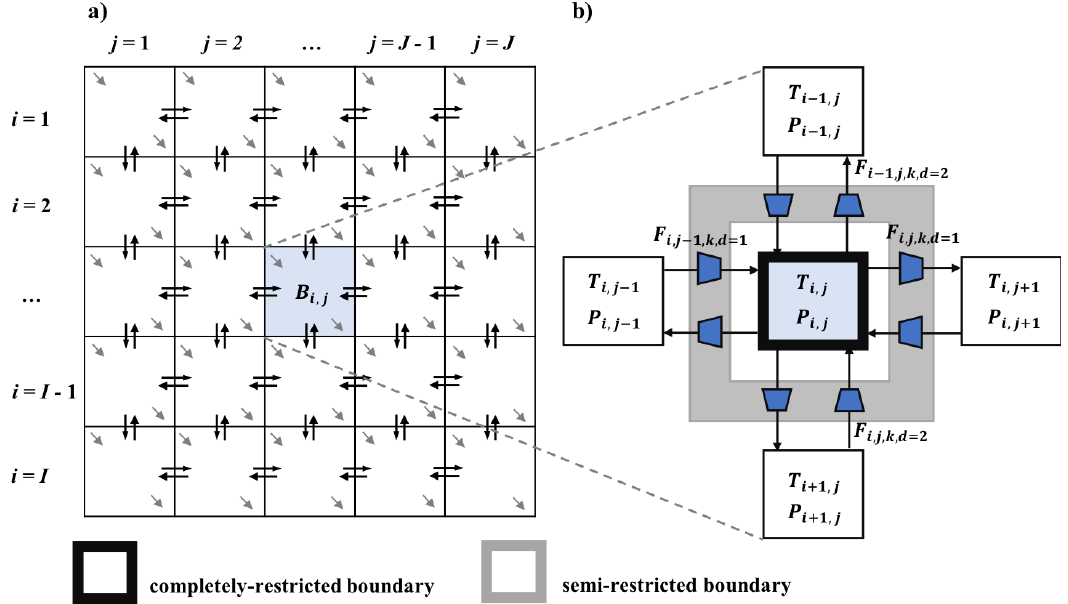
Figure 4. A general superstructure representation using building blocks for work and heat integration in WHENS: ( a ) General block representation; ( b ) Interaction of blocks through boundaries and connecting